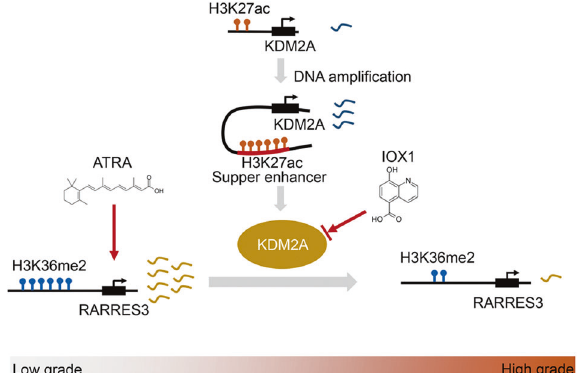
Fig. 7 Schematic model of KDM2A regulation in human bladder cancer. Schematic model showed regulation of KDM2A in human bladder cancer. KDM2A was frequently ampli fi ed and implicated in SEs formation in high-grade bladder cancer. Frequent upregulation of KDM2A was attributed to decreased H3K36me2 enrichment at tumor suppressor RARRES3, thus downregulating mRNA levels. The combination of IOX1 (KDM2A inhibitor) and ATRA (RARRES3 activator) can reverse this regulatory